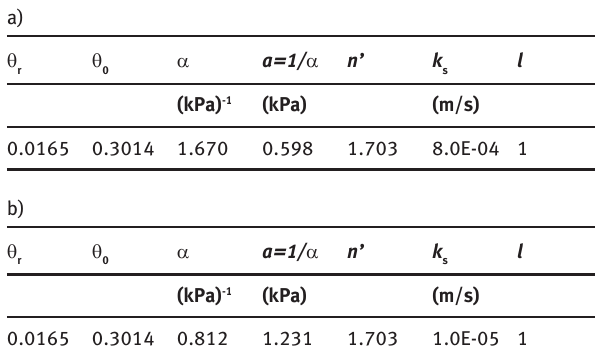
Table 6: Hydraulic function parameters: a) at the first infiltration test; b) at the second infiltration test